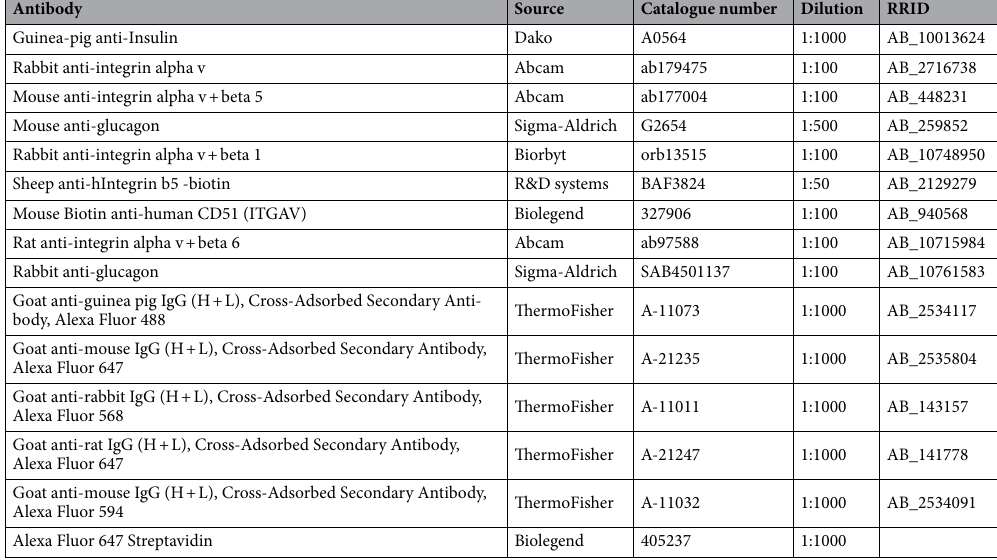
Table 3. Antibodies used for immunofluorescence and flow